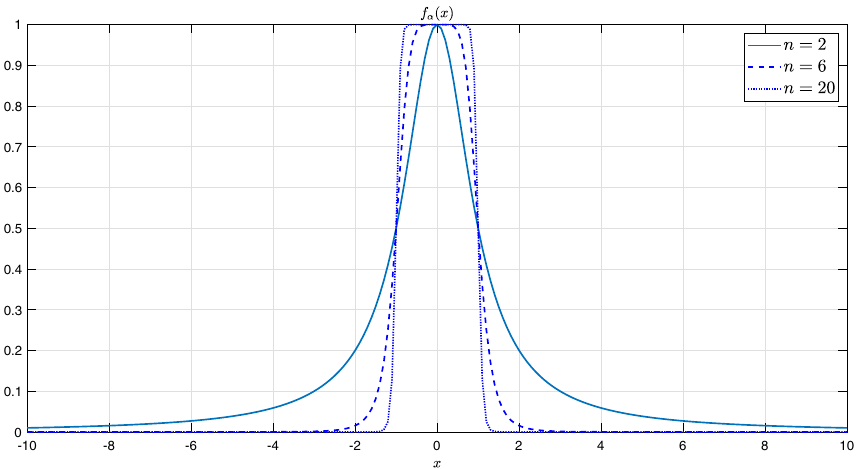
Figure 1. f α ( x ) for different values of n , using α = 1